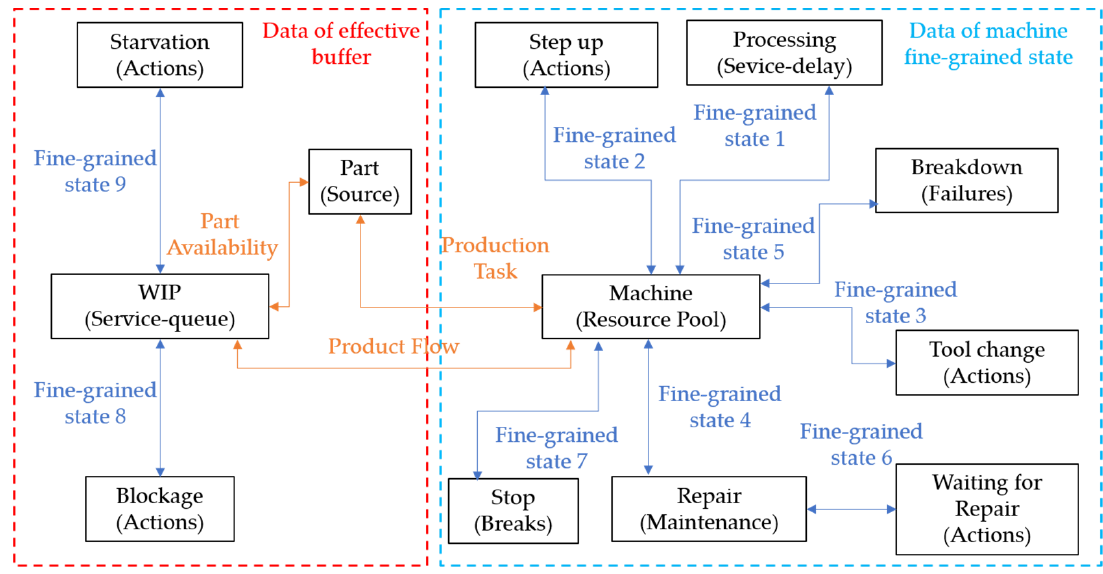
Figure 11. The logical relationship between agents.